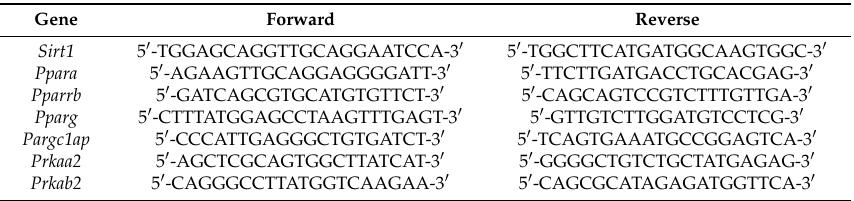
Table 1. Quantitative real-time polymerase chain reaction primers